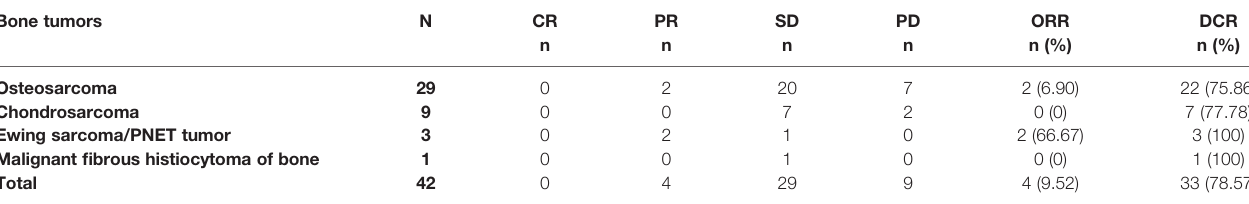
TABLE 2 | Best overall responses by tumor types.